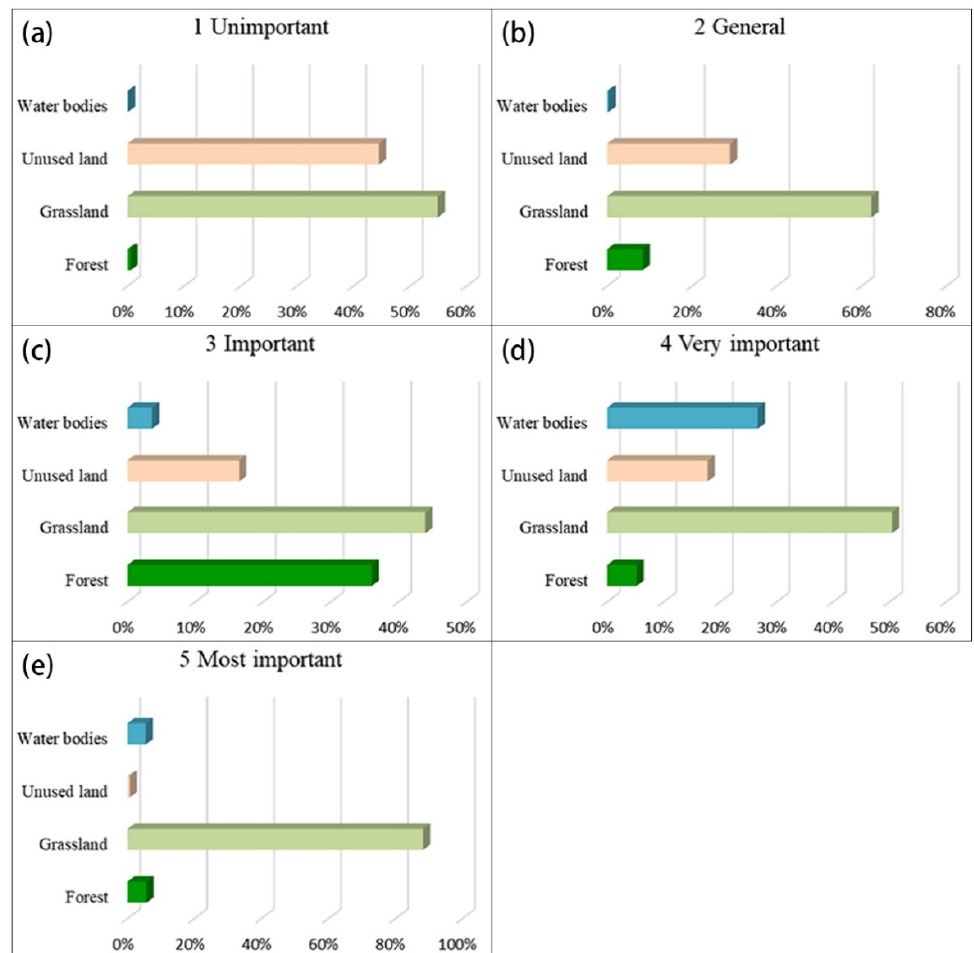
Figure 6. Percentages of the five types of ecological land as a proportion of all ecological land types within each level: ( a ) unimportant ; ( b ) generally important ; ( c ) important ; ( d ) very important ; ( e ) most important